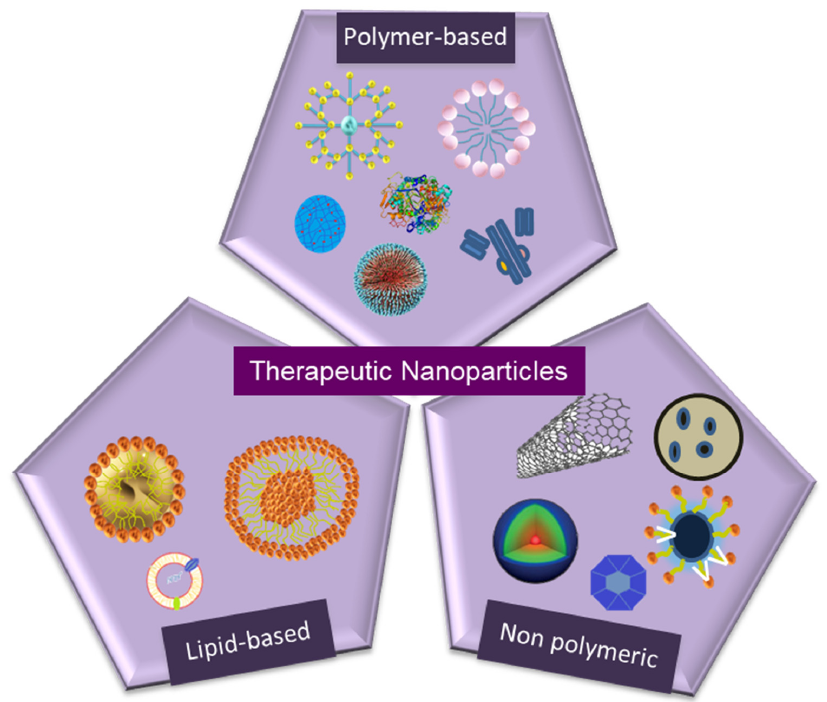
Figure 2. Schematic representations of the therapeutic nanoparticles.